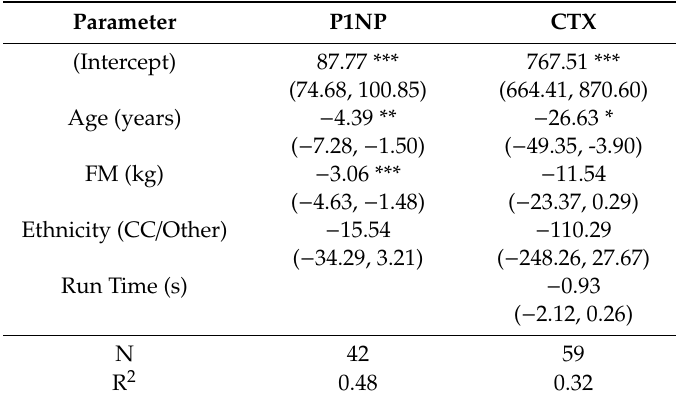
Table 2. Coe ffi cients for each regression model. These coe ffi cients are the values related to the significant models for predicting bone formations and resorptions and can be used to predict these outcomes. Coe ffi cients are presented as coe ffi cient and 95% CI (lower, upper). Parameter